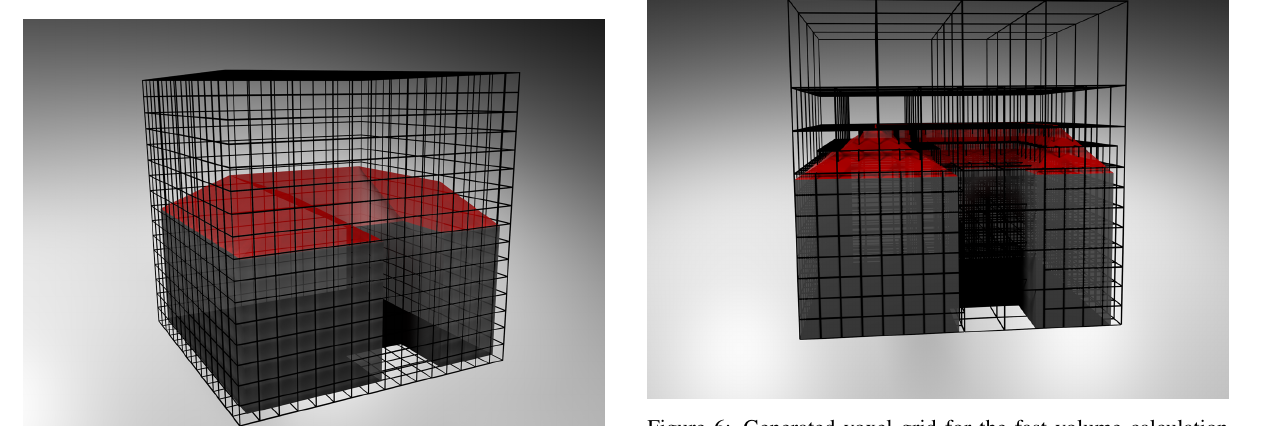
Figure 6: Generated voxel grid for the fast volume calculation method. Starting from an initial voxel the voxel is only subdi- vided if the voxel contains any part of the building’s boundary